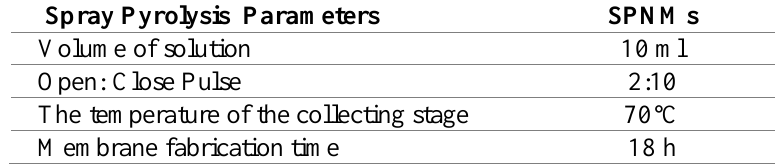
Table 4: Spray Pyrolysis conditions of SPNMs.